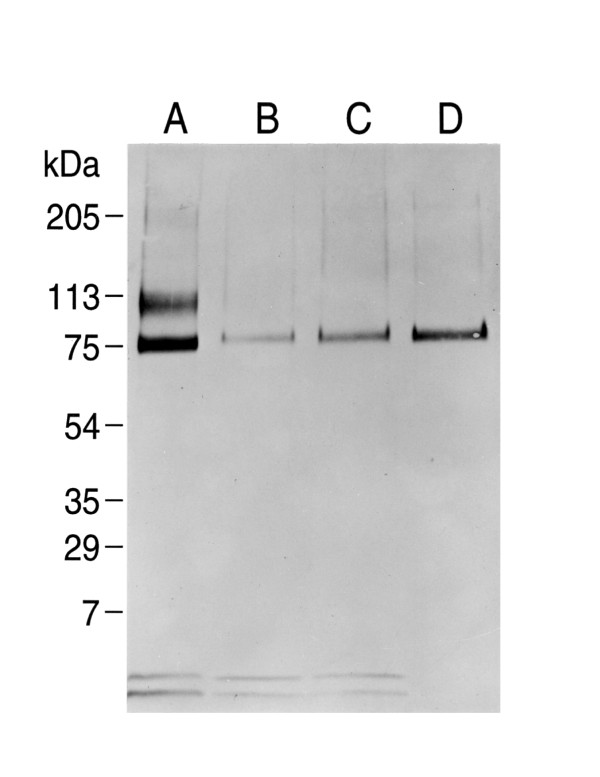
Western blots of SDS-PAGE protein samples before (A) and after (B, C, and D) each enrichment step. Western blots were performed using GP1. Although the identity of the samples applied to each lane was the same as illustrated in Figure 3, the amount of protein applied to each lane differed. (A). Fraction Sp, 5 μg, (B). Galactose eluted protein from the RCA column containing L-Arg stimulated ion channel activity, 1.6 μg, (C). Protein from the first peak fractions of the gel filtration step containing L-Arg stimulated ion channel activity, 0.2 μg, (D). Protein fraction containing L-Arg stimulated ion channel activity from the pH 9 fraction of the ion exchange procedure, 0.2 μg. Note that in spite of lowering protein amounts in lanes A – D, the intensity of the Western blot increases, indicative of an enrichment of the antigen protein(s) near 82–84 kDa.